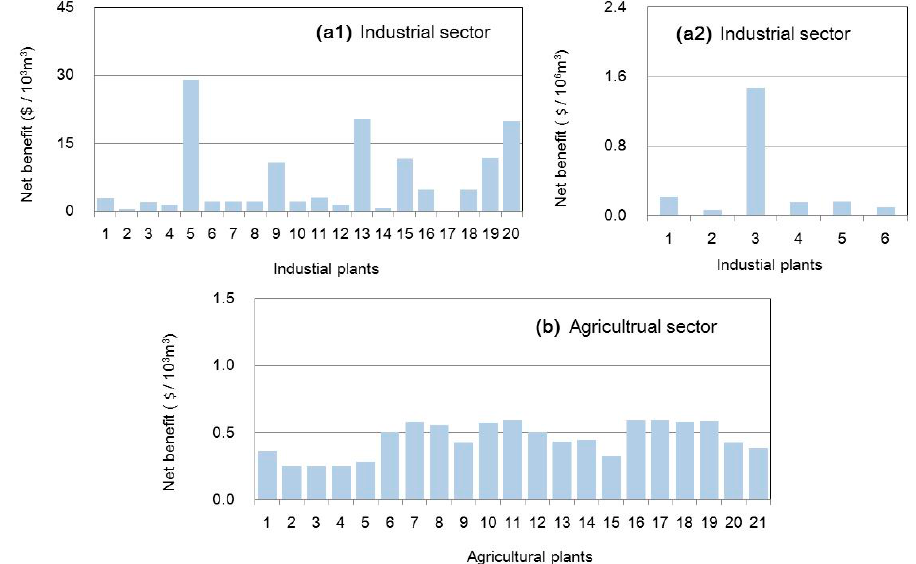
Figure 4. Net benefit among industrial and agricultural sectors. (figure ( a1 ) presents net benefits in industrial sectors with lower values; figure ( a2 ) presents net benefits in industrial sectors with higher values; figure ( b ) presents net benefits in agricultural